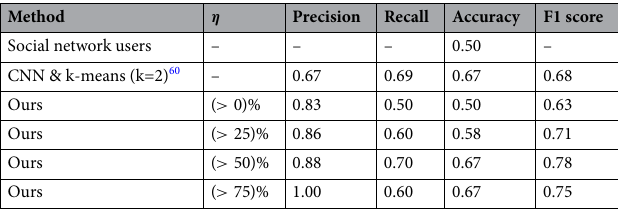
Table 1. Comparison of evaluation